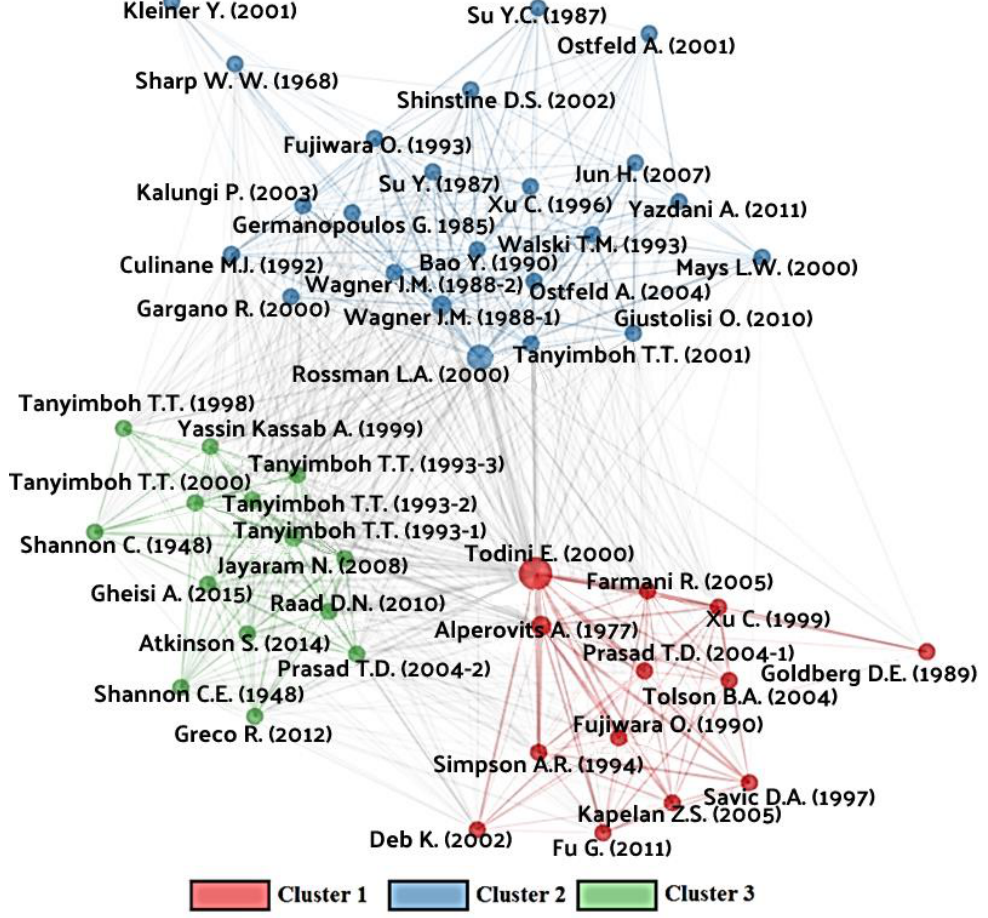
Figure 7. Author co-citation network. These articles have been commonly cited by the original articles. Node size represents the number of articles that have cited the article and links represent that they appear as a common citation in one or more articles. Table 5. Clustering of co-cited articles.